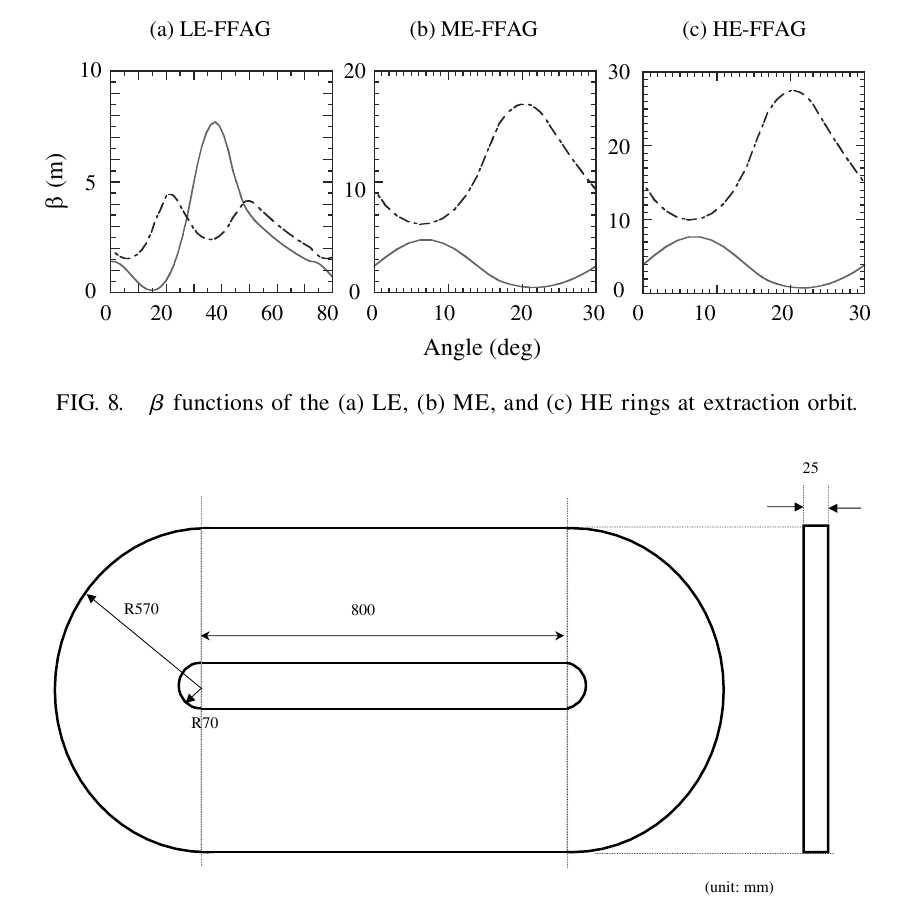
FIG. 9. Racetrack shape of a preliminary MA core.